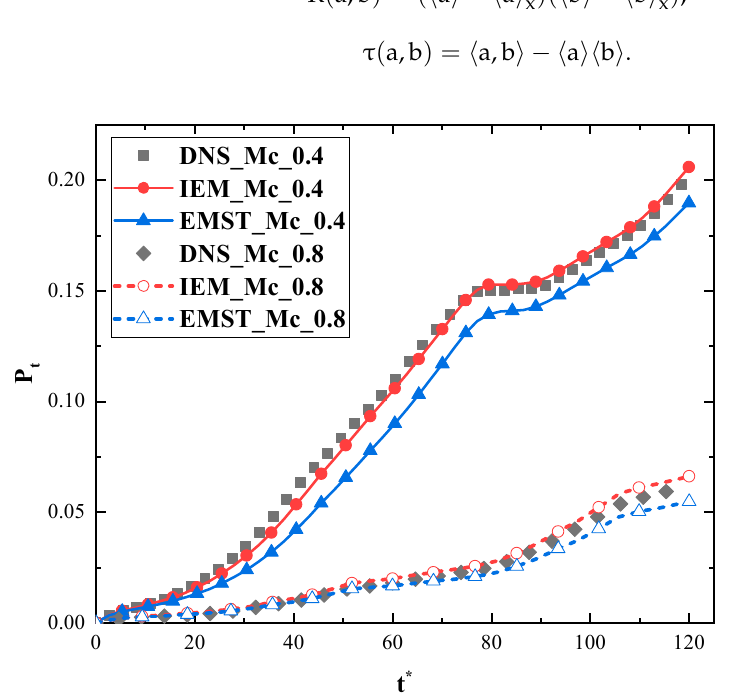
Figure 6. Mean of the total product mass fraction versus dimensionless time for different values of convective Mach number.